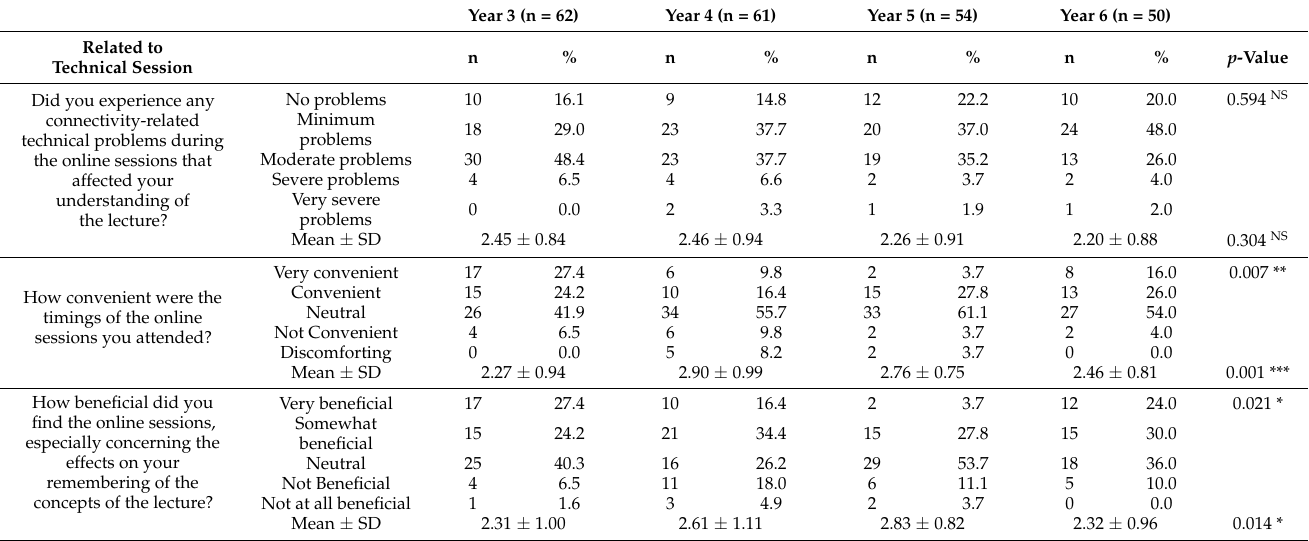
Table 5. Distribution of responses related to technical session according to level of